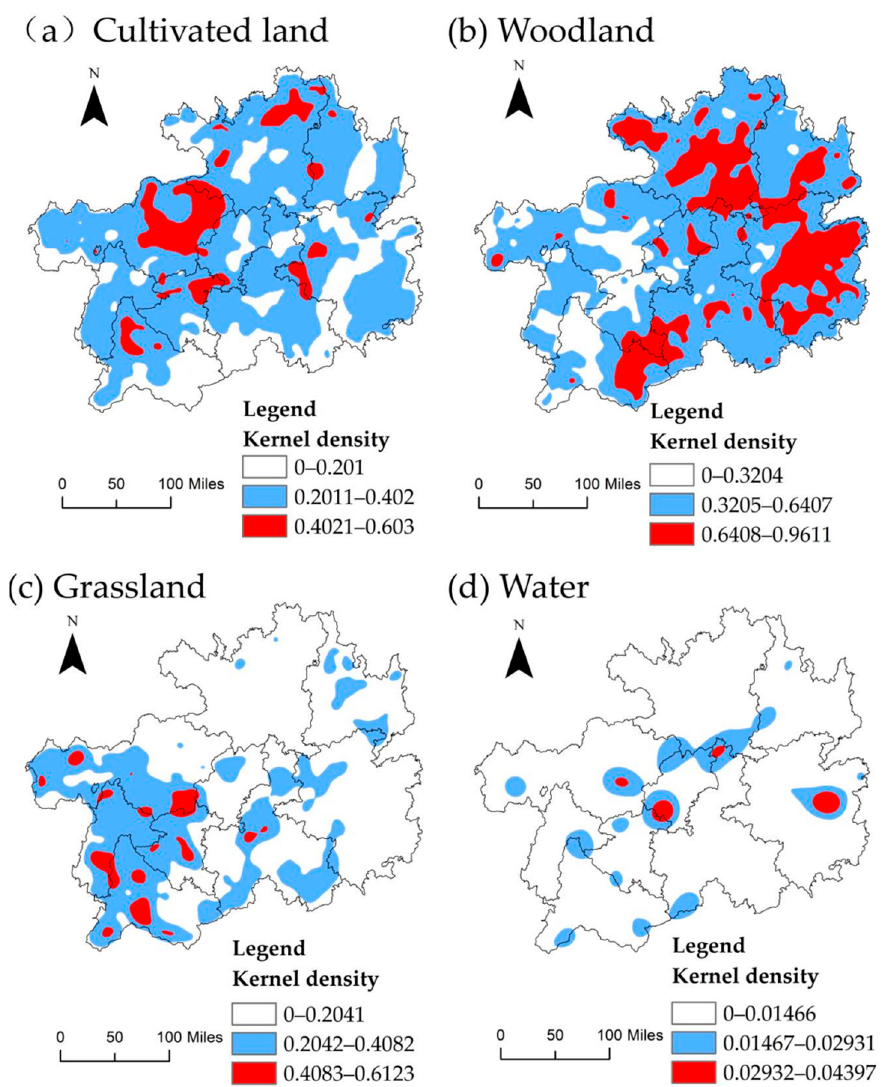
Figure 7. Spatial distribution of different types of ecological resources:.